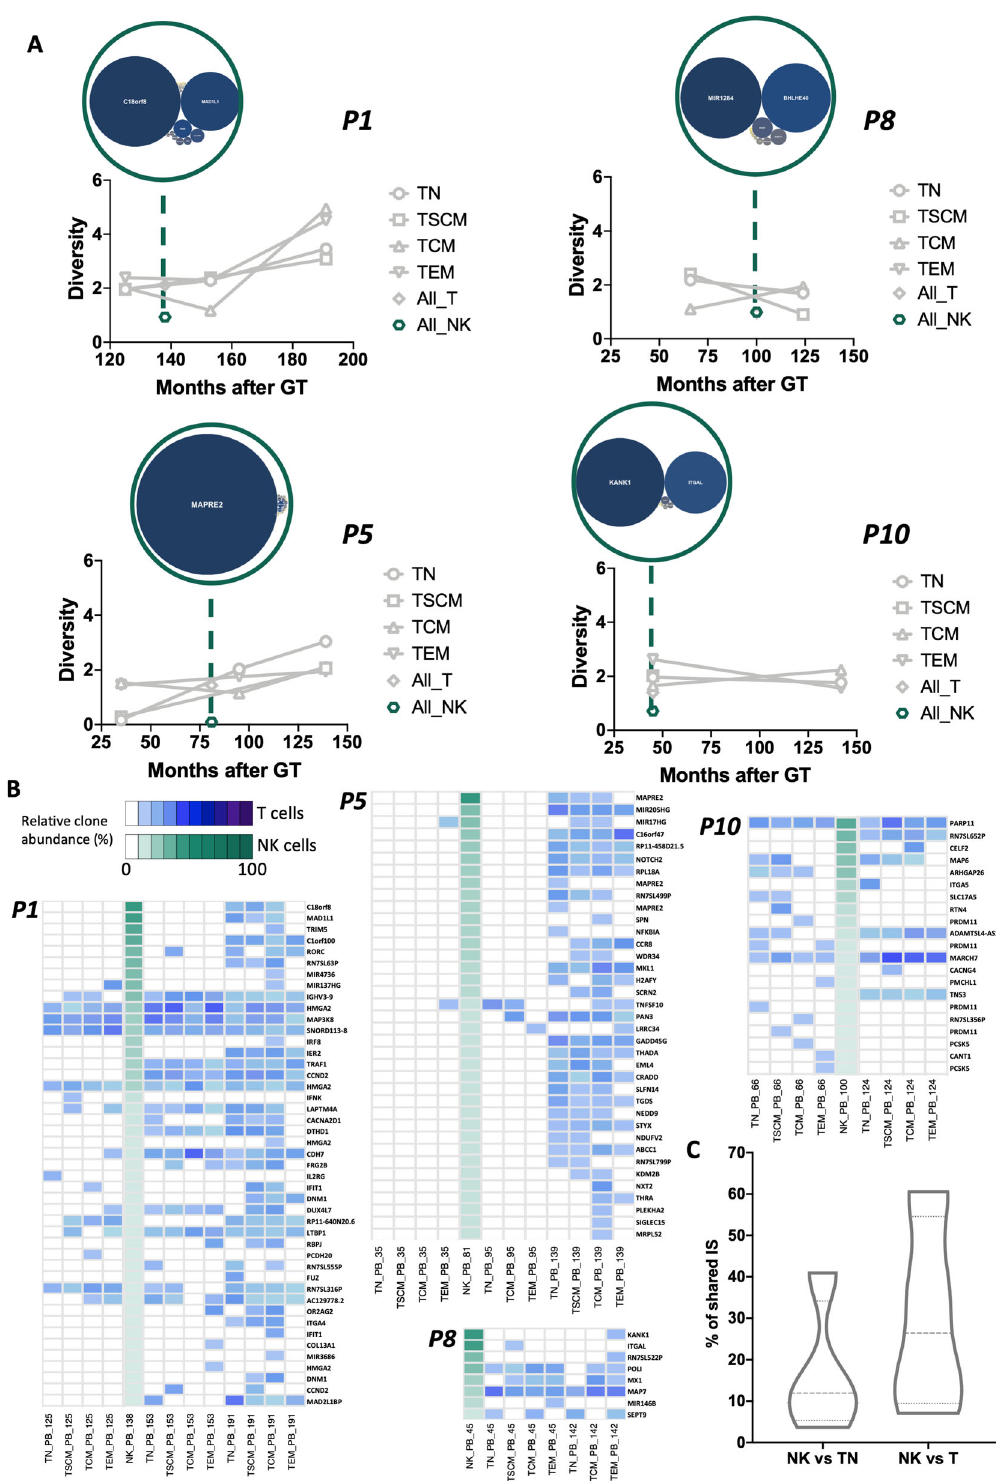
Fig. 7 Analysis of integration sites in NK cells. A Plots showing Shannon Diversity Index of IS overtime in NK cells (green dots) and in the other T-cell subtypes (grey lines). At each timepoint analysed green circles contain bubble plots of clones contributing >0.01% to the total NK population. Dimension of the bubble is proportional to the size of the clone. The name of the gene closest to the relative IS is reported inside the bubble. B Heatmaps displaying integration sites shared between NK cells and T cell subtypes in each patient. Each row is named by the name of the closest gene while each column is labelled by sample and timepoint (number of months after GT). Intensity of green (NK) or blue (T-cell subtypes) colours is proportional to the abundance of each integration site (white = not detected). C Violin plots showing the percentage of NK IS shared with at least one TN (NK vs. TN) or T cell-subtype (NK vs. T) in all